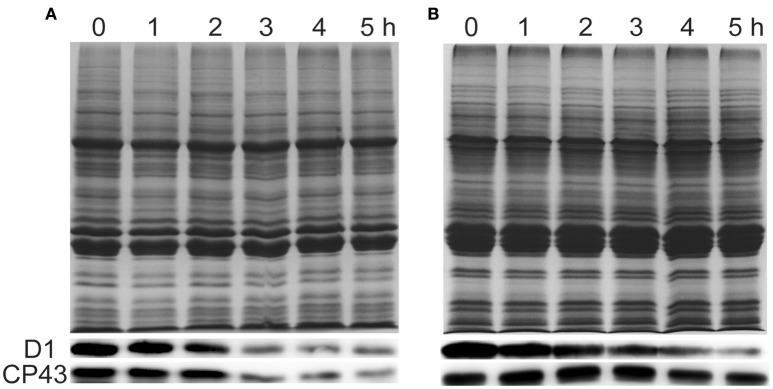
Immunoblot analysis was performed using an antibody specific to D1 and CP43 (lower panels). Equal loading was confirmed by Coomassie brilliant blue staining (upper panels). (A,B) Represent Chlorella strain FACHB-1216 and FACHB-1563, respectively.